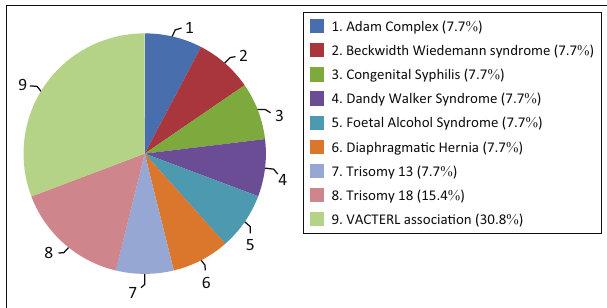
FIGURE 5: Specific syndromes or patterns of congenital abnormalities.